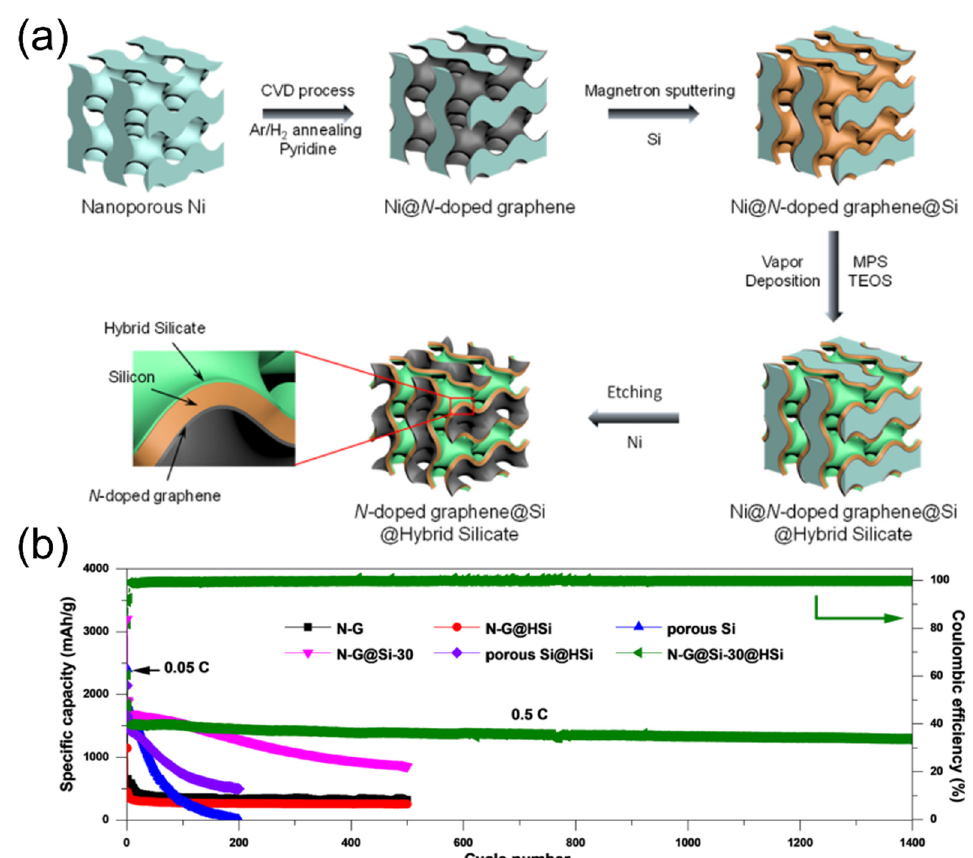
Figure 9. ( a ) Schematic drawing illustrating the fabrication process of the nanoporous N-G@Si@HSi anode. ( b ) Cycling performance of the N-G, N-G@HSi, porous Si, N-G@Si-30, porous Si@HSi, and N-G@Si-30@HSi electrodes at 0.05 C for the initial three cycles and at 0.5 C for the extended cycles. Reproduced with permission from ref. [54]. Copyright 2020, ACS